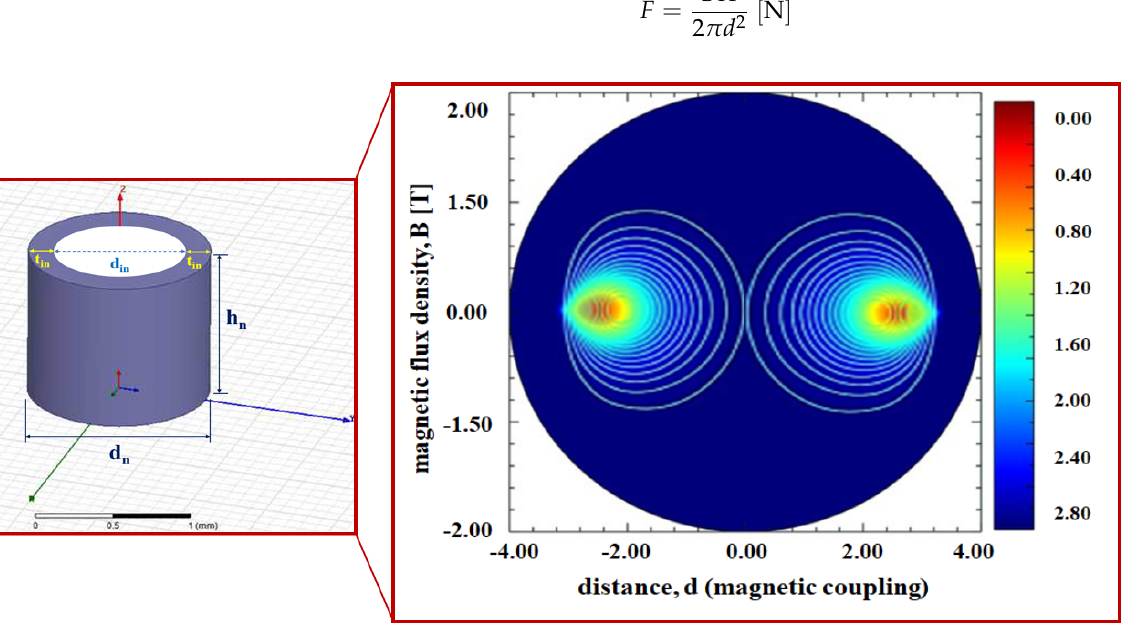
Figure 4. Structure of the magnet and simulation result of the magnetic flux density with respect to the distance from the magnet.